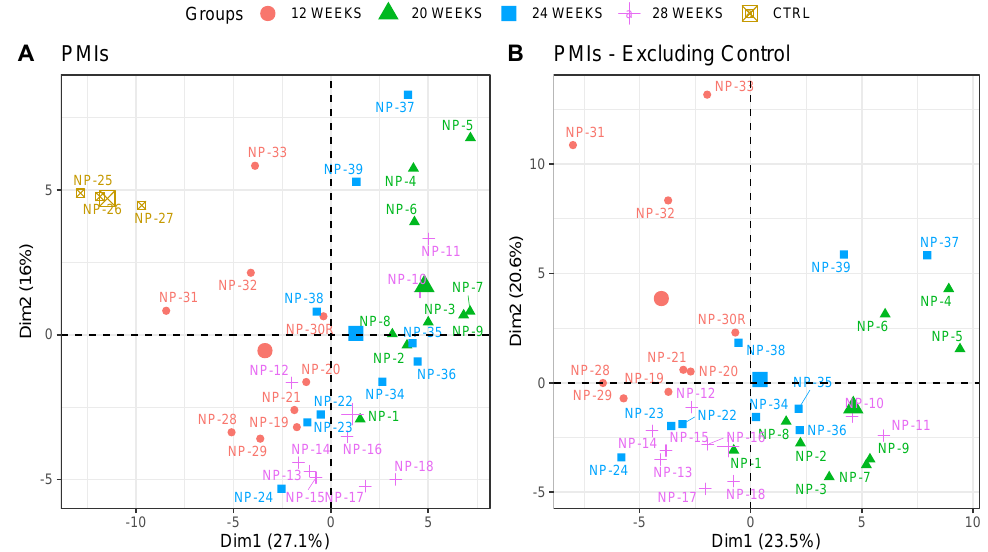
Figure 1. PCA plot representing the samples grouped by their PMIs; ( A ) including control samples, and ( B ) excluding control samples. The same-coloured icons indicate the same PMI, as reported in the legend. Control (CTRL) = 0 weeks PMI. Protein abundances used for the PCAs were the ones whose q values were significant between the different conditions ( n = 90, q < 0.05). The bigger icons in the plot for each group represent the centroids of the samples in the group.